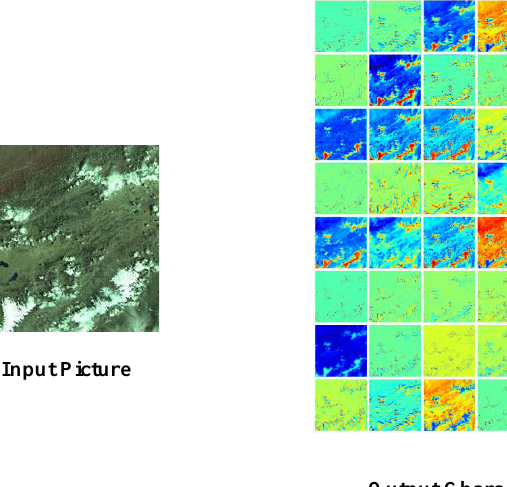
Figure 6. L1 layer feature heat map in